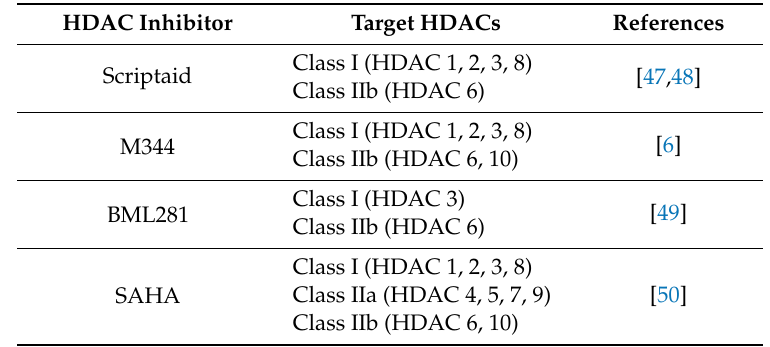
Table 1. Target HDACs sub-classes of four pan-HDAC inhibitors (Scriptaid, M344, BML281, and